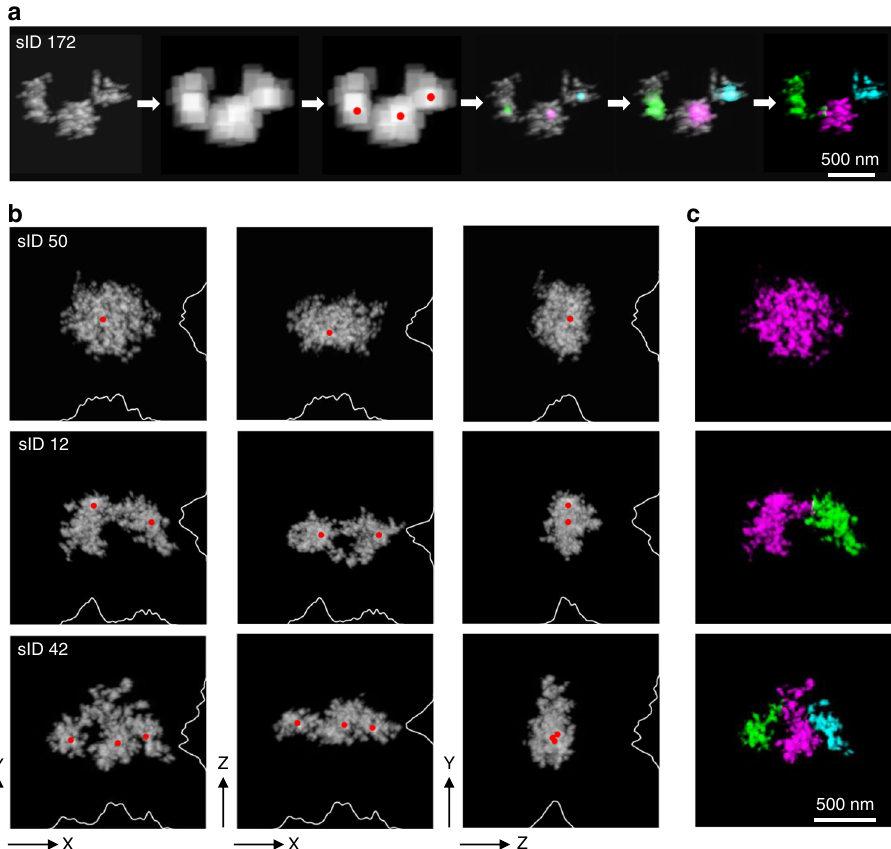
Fig. 3 3D-EMISH distinctive chromatin-folding domain identi fi cation. a 3D-EMISH image-processing steps to identify distinctive chromatin-folding domain. We smoothed out 3D-EMISH image to remove fi ne-grain feature, searched for distinctive folded sub-domains, and calculated the center point of each domain, represented as red dots. Applying diffusion process, starting from each center point to cover all voxels in 3D image, we identi fi ed